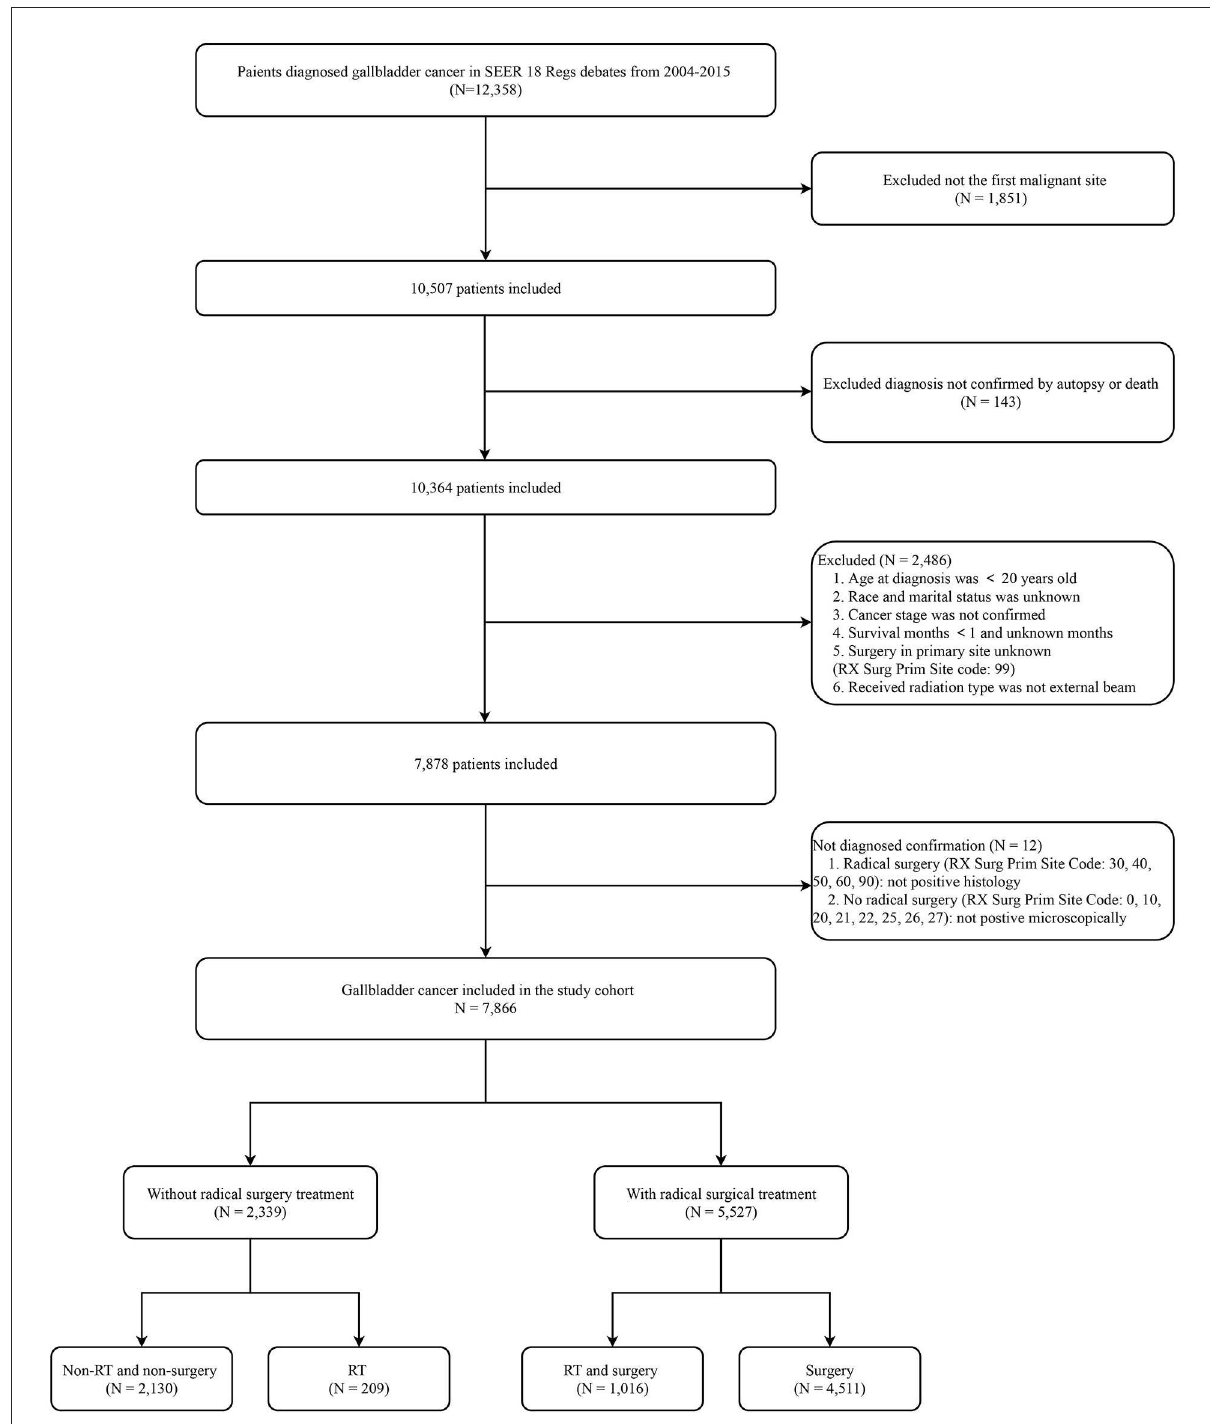
FIGURE1 Flow chart for study enrollment. RT, radiotherapy; SEER, Surveillance, Epidemiology, and End Results.